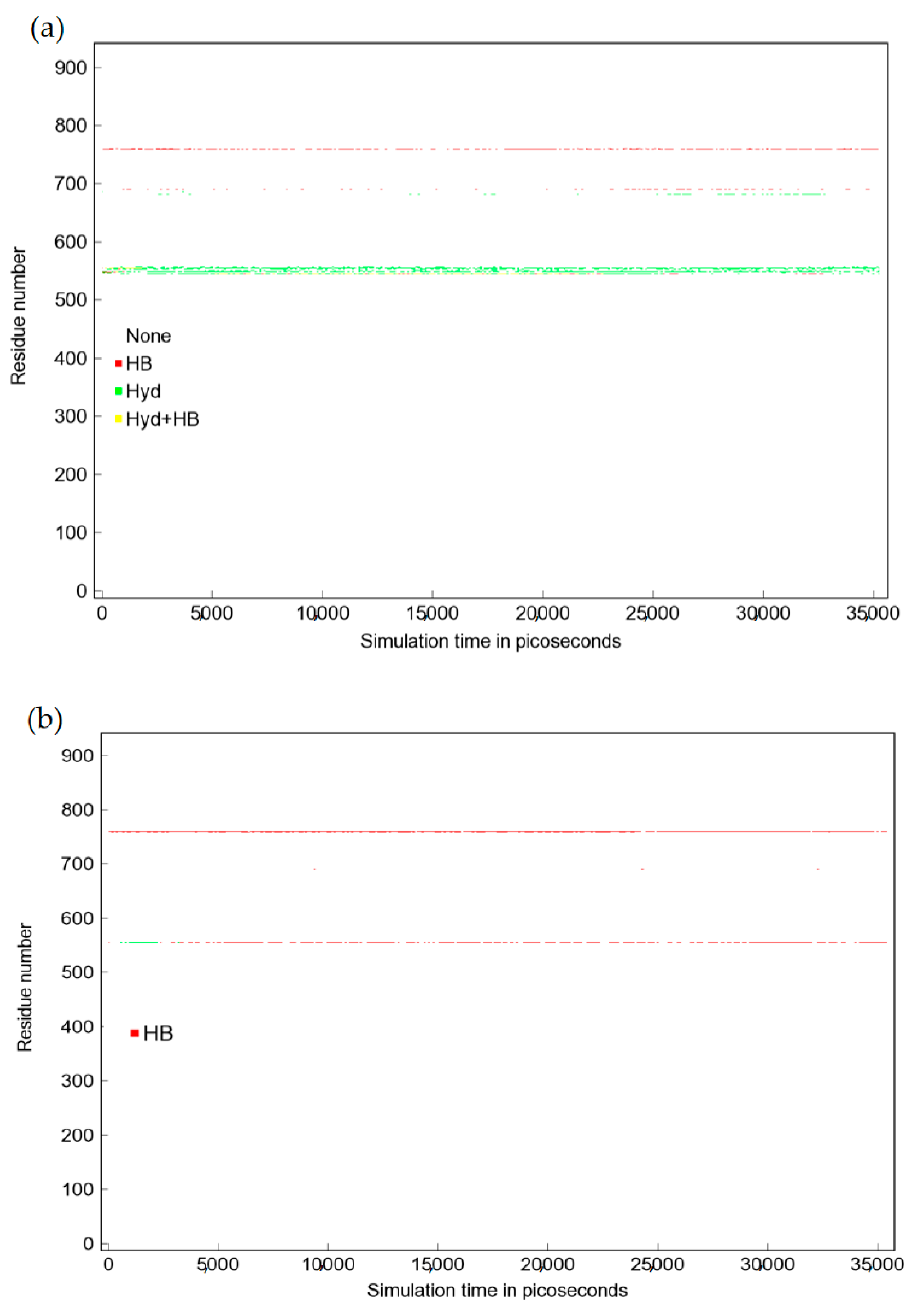
Figure 11. Per-residue contacts including H-bonding (in red) and hydrophobic (in green) interac- tions in function of the time involved for: ( a ) compound 6 and ( b )